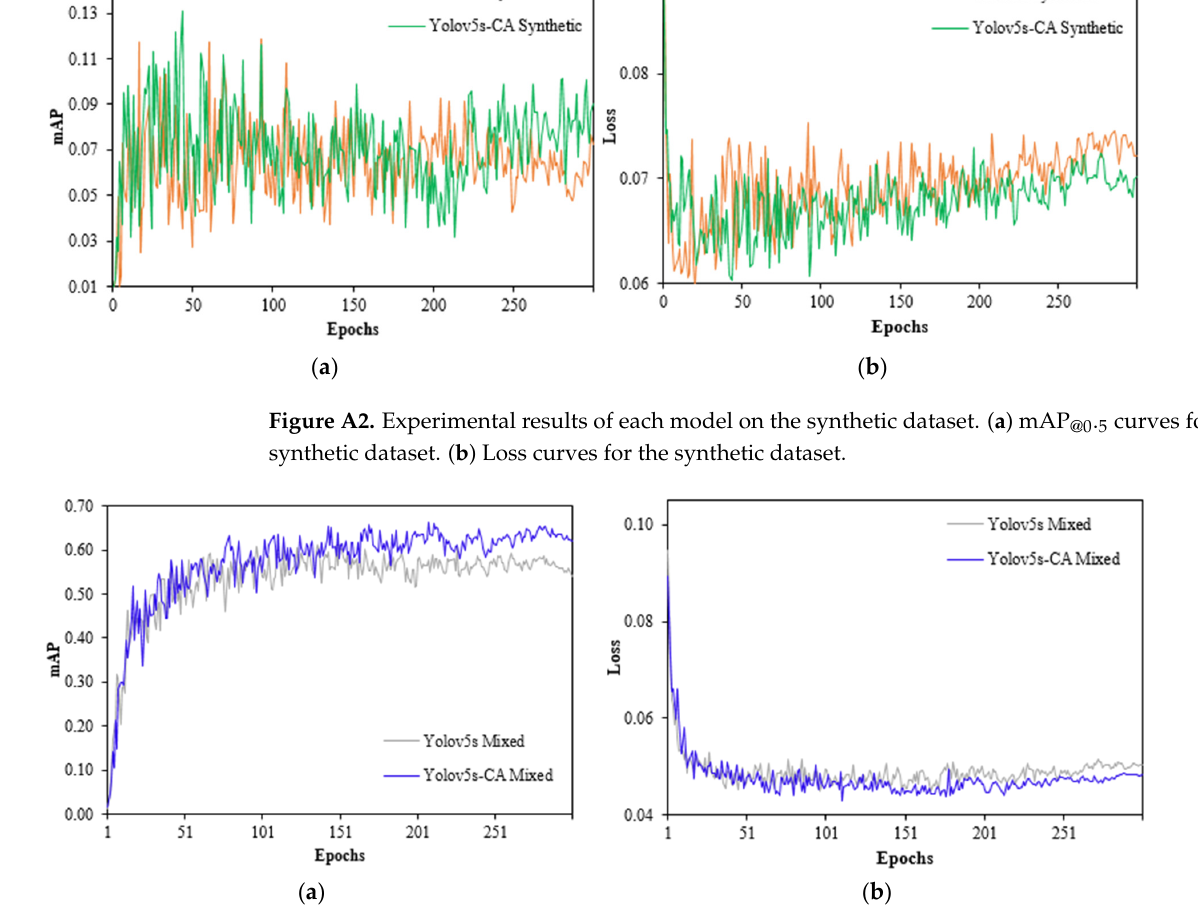
Figure A3. Experimental results of each model on the mixed dataset. ( a ) mAP @0 . 5 curves for the mixed dataset. ( b ) Loss curves for the mixed dataset.